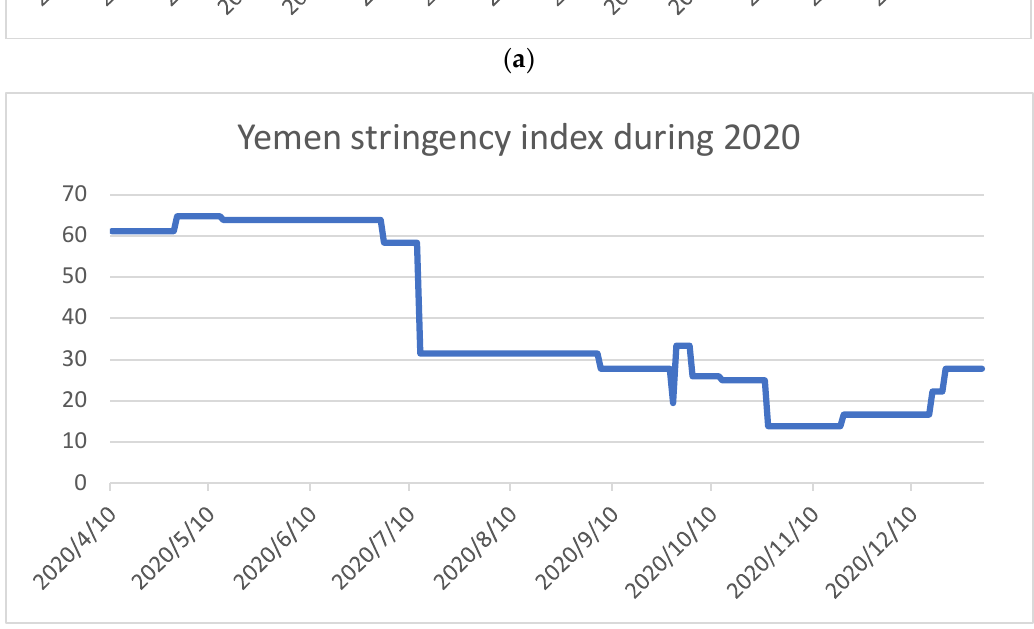
( c ) Figure 1. ( a ) Yemen Stringency Index; ( b ) Yemen Stringency Index from 10 April 2020 till the end of 2020; ( c ) Yemen Stringency Index during 2021. 3.2. The Human Movement after the Introduction of Containment Measures during 2020 and 2021 in Yemen The Human mobility (Figure 2a and b) show the change in the movement of the pop- ulation in comparison to previous years. Looking into (Figures 1a and 2a together), it is to be noticed that even during March, before the announcement of COVID exitance in Yemen, the population movement decreased slightly more than usual.